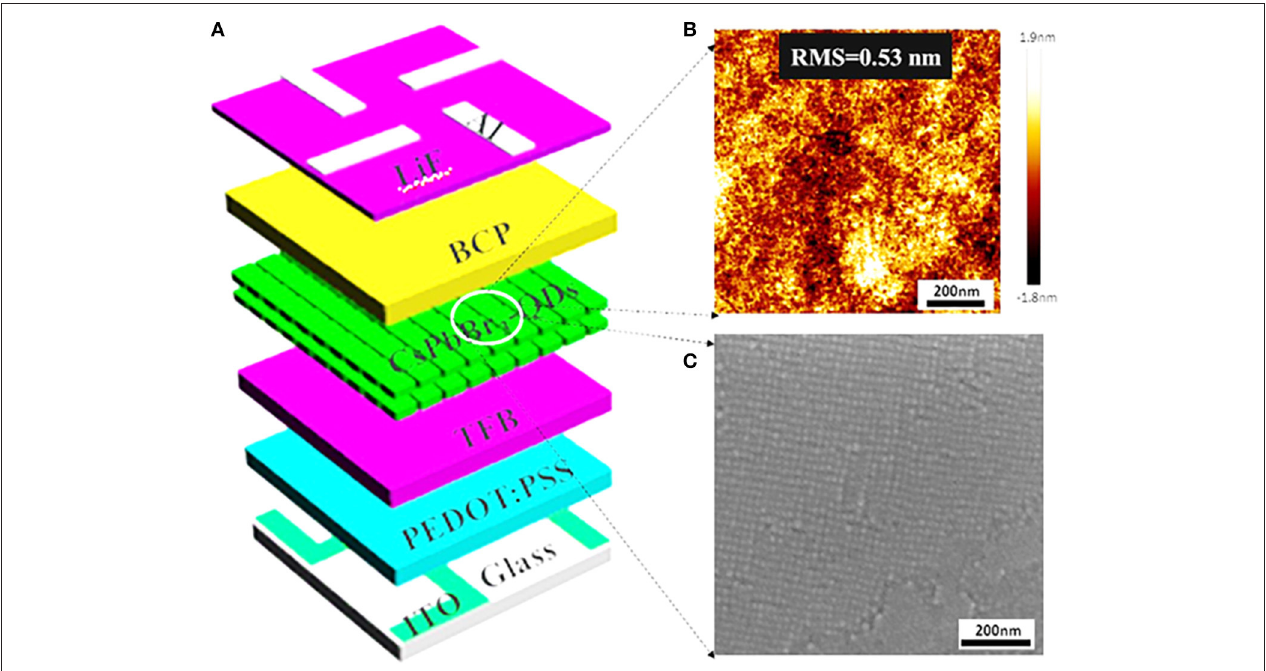
FIGURE 4 | (A) Schematic illustration of the QLEDs with a multilayered structure, consisting of ITO/HIL/HTL/perovskite CsPbBr 3 QDs/BCP/LiF/Al. (B) AFM measurement shows the surface roughness of the spin-coated CsPbBr 3 QDs films (Rq = 0.53nm) in the device configuration. (C) Surface SEM image of uniformly, compactly packed CsPbBr 3 QDs.